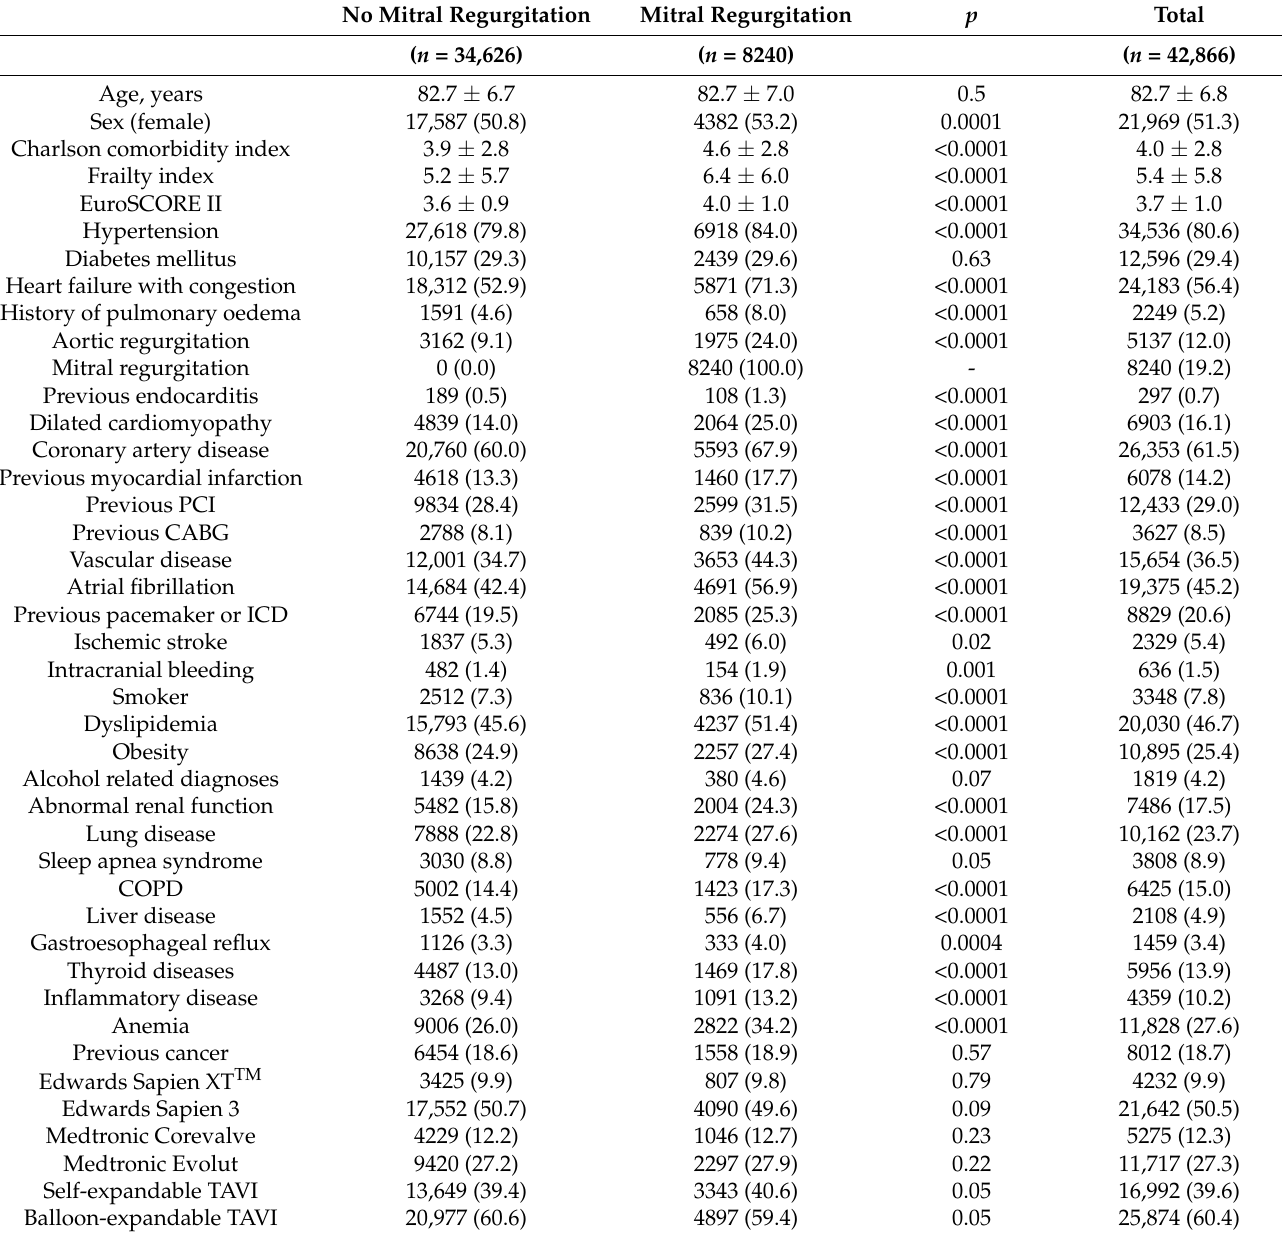
Table 1. Baseline characteristics of patients treated with TAVI according to baseline mitral regurgitation.